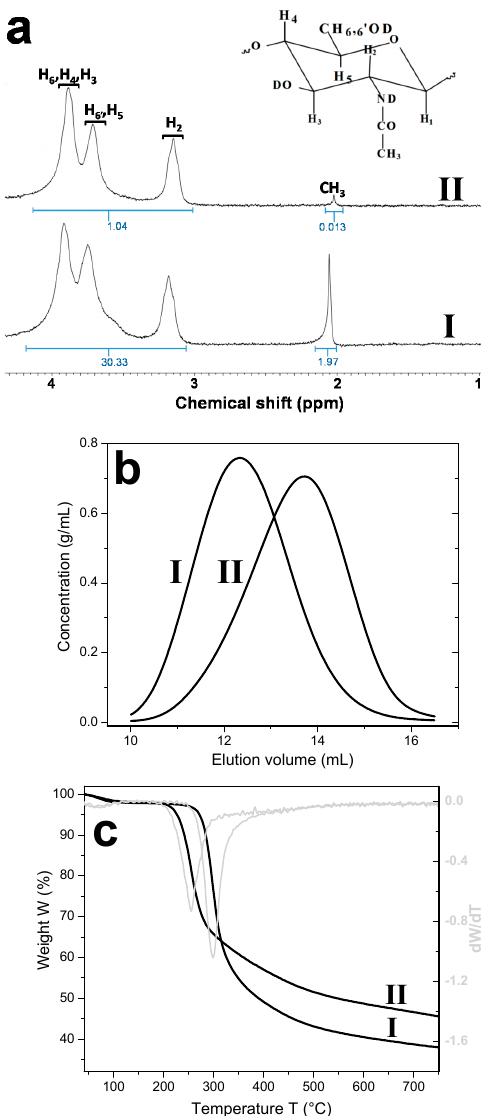
Figure 1. ( a ) 1 H NMR spectra of: (I) the low molecular weight chitosan (LMW CHI (raw material)) and (II) the highly deacetylated low molecular weight chitosan (deacetylated-LMW CHI), with values of signals integrated intensities written in blue; ( b ) size exclusion chromatography (SEC) chromatograms of: (I) LMW CHI and (II) deacetylated-LMW CHI; ( c ) thermogravimetric analysis (TGA) of: (I) LMW CHI and (II) deacetylated-LMW CHI. Table 1. Macromolecular structure parameters of the di ff erent chitosans. Type of Chitosan Mn (g / mol) HMW